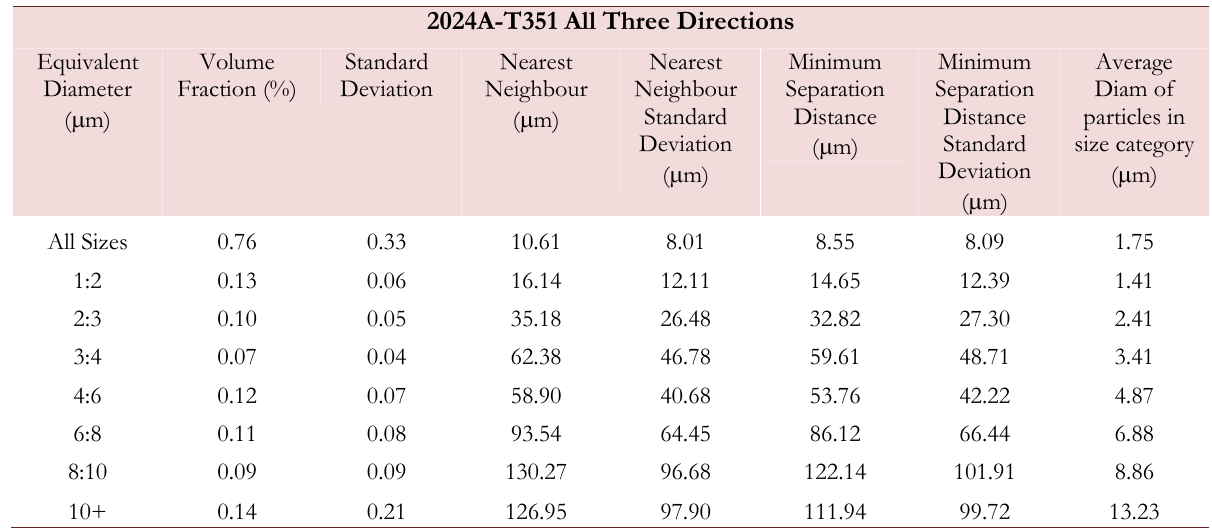
Tabella 1: Defects size distribution.